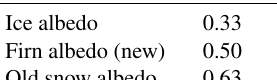
Table 1. Albedo parameters used in the CMB model. Parameter Value